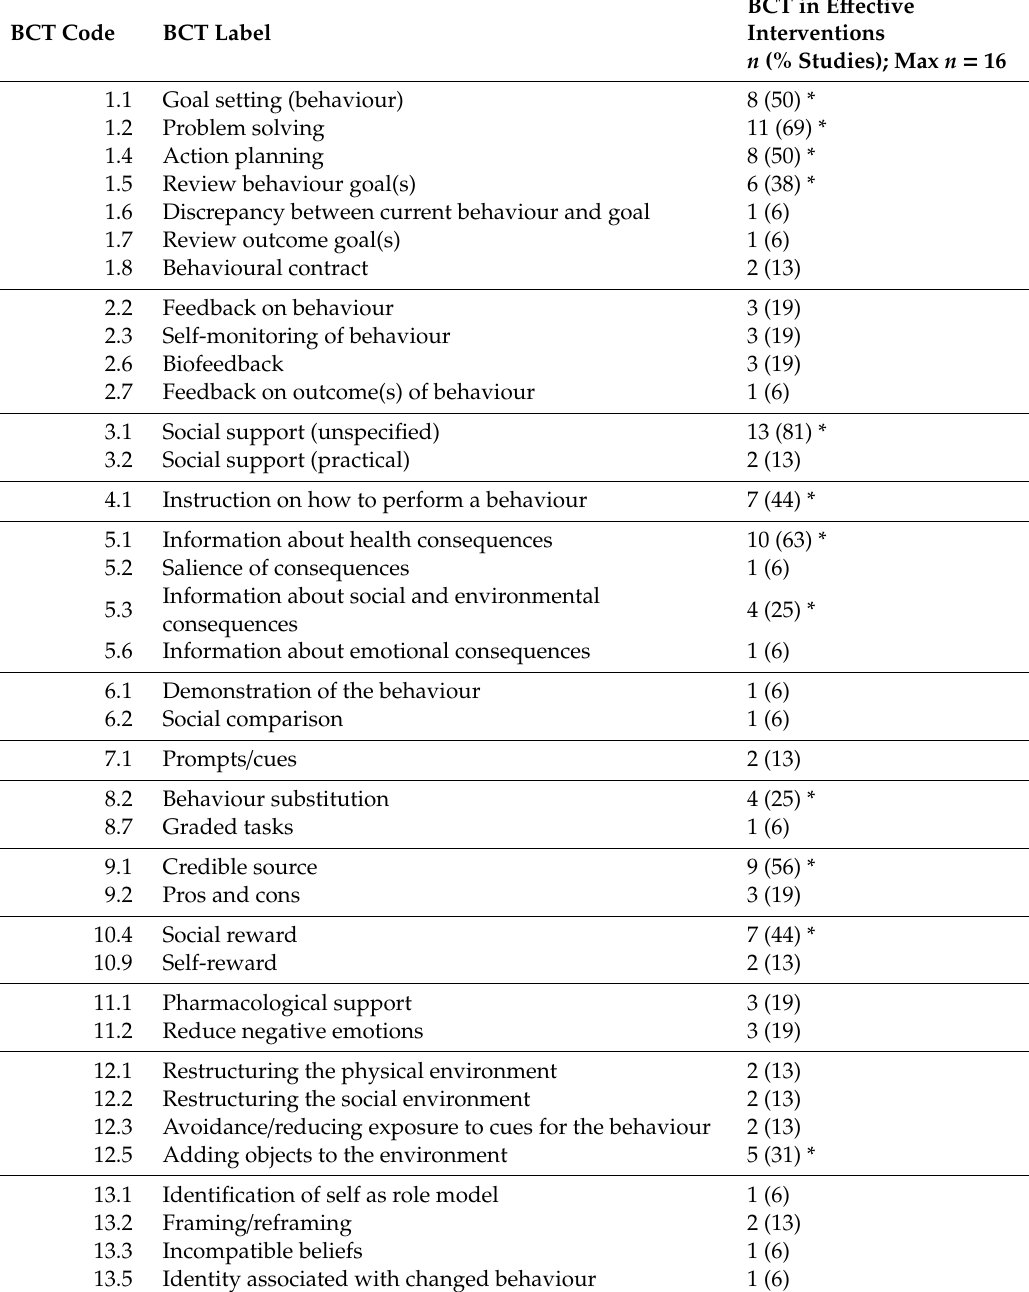
Table 1. Frequency of behaviour change techniques (BCTs) identified in interventions to reduce environmental tobacco